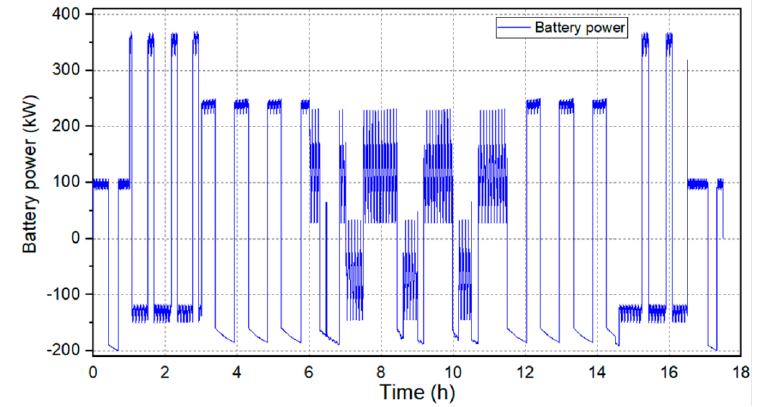
Figure 15. Battery power variation during operation.